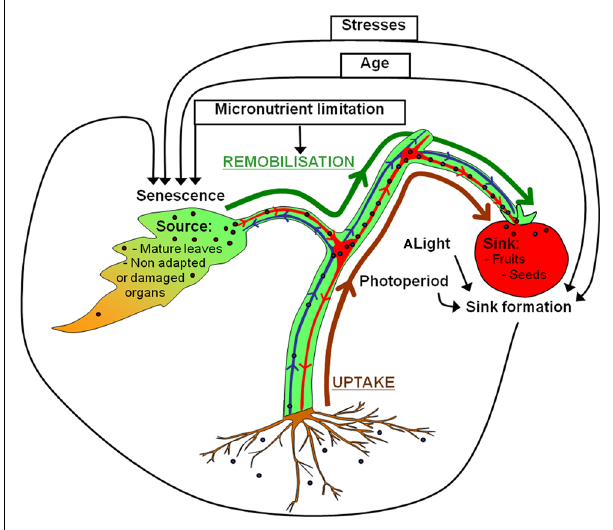
FIGURE 1 | Uptake and remobilization pathways involved in seed filling with emphasis on source-sink relationships. Micronutrients from the rhizosphere (brown arrow) are taken up into roots and transported to the xylem vessels (shown in blue). After xylem loading, micronutrients are translocated into shoots for subsequent unloading. Micronutrients located in the xylem can also be unloaded into the xylem parenchyma of nodes to be transferred to phloem vessels (shown in red) by specific transporters (Sondergaard etal., 2004;Tanaka etal., 2008;Yamaji and Ma, 2009).This is essential for seed filling which is only achieved by the phloem sap (Patrick and Offler, 2001). Phloem micronutrients are unloaded to fill seeds. Because seed filling is also achieved by nutrient remobilized from senescent tissues (green arrow), seed formation requires close synchronization between sink formation and source organ senescence. Age, biotic and abiotic stresses contribute to orchestrate nutrient mobilization during leaf senescence with the formation of reproductive organs and seed filling (black arrows). Light and photoperiod act indirectly on leaf senescence by stimulating the development of the reproductive